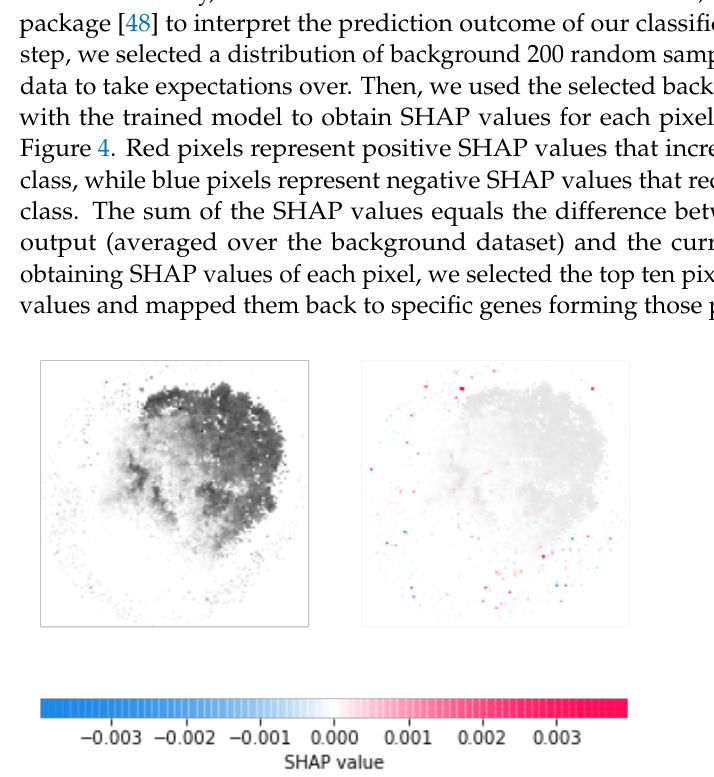
Figure 4. Left side is gray-scale image of an ALS sample. Right side shows highlighted pixels in the image with SHAP